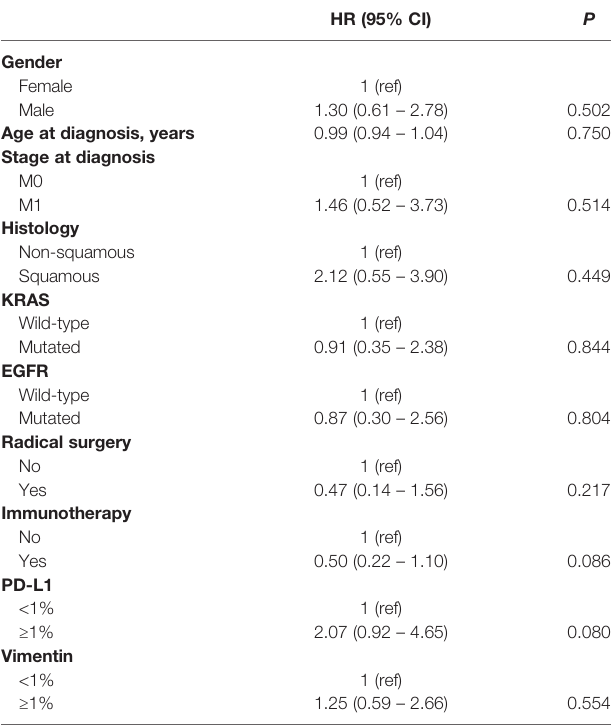
TABLE 2 | Results from Cox univariate analysis for